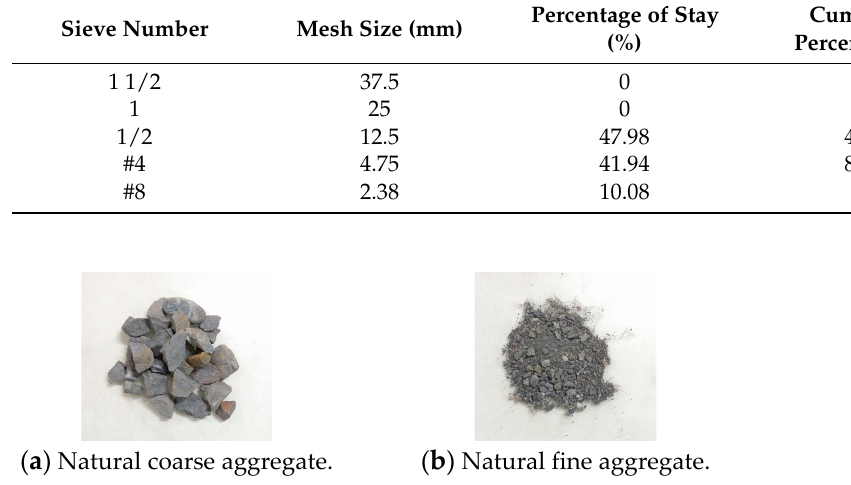
Figure 1. Appearance of natural coarse